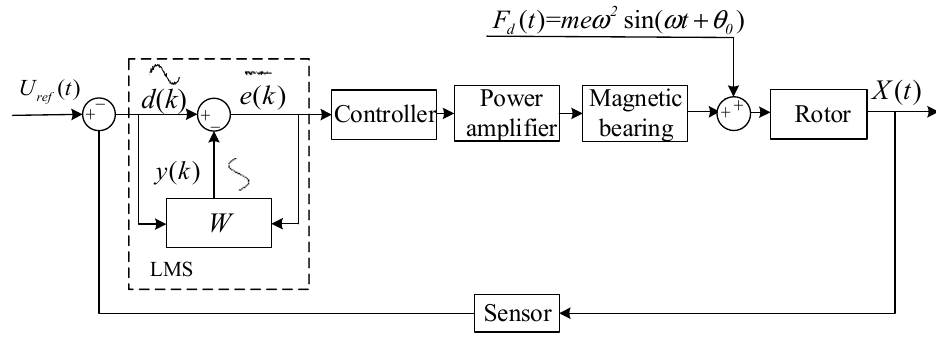
Figure 2. Principle of unbalanced vibration suppression control algorithm for maglev rotor.